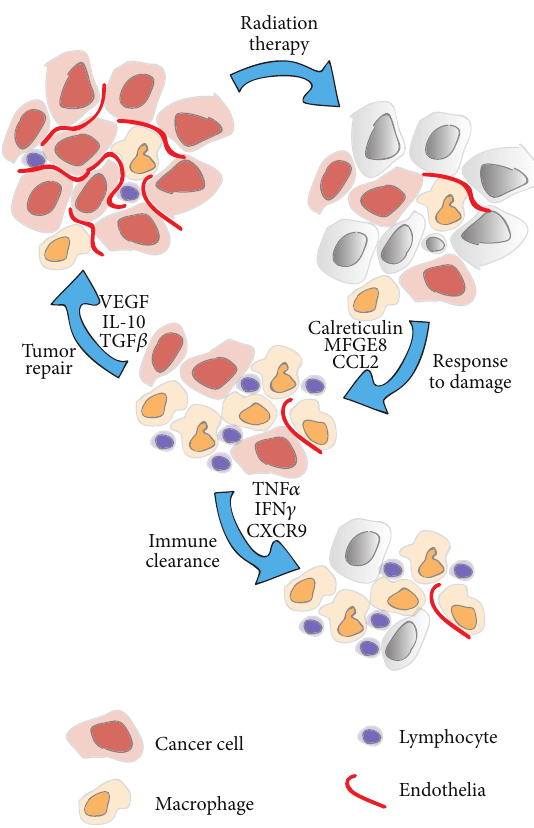
Figure 1: Tumor destruction or repair following cytotoxic therapy. High dose radiation therapy of tumors results in death of cancer cells, endothelial cells, and lymphocytes, but small numbers of cancer cells with clonogenic potential can survive. Cancer cell death triggers phagocytic receptors on radioresistant tumor macrophages and results in recruitment of both lymphocytes and macrophages to the treatment site. The immune response and the inflammatory milieu at the treatment site may influence outcome; a proinflam- matory environment can permit immune-mediated clearance of residual cancer cells, while an anti-inflammatory environment can suppress adaptive immunity and repair the tumor environment for cancer